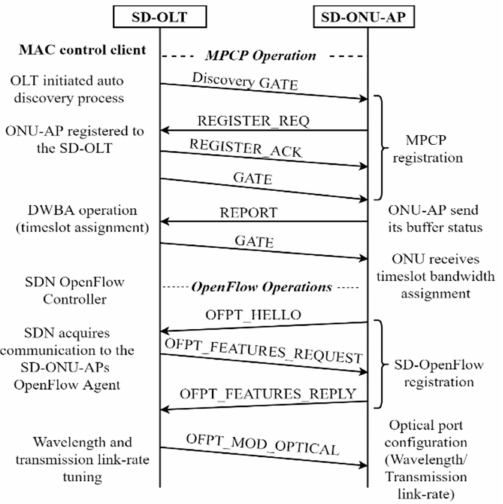
Figure 5. Combined multipoint control protocol (MPCP) and OpenFlow